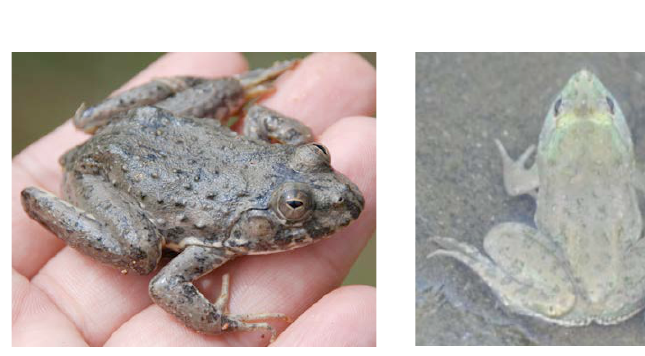
Image 3. Euphlyctis cyanophlyctis , Ngera Ama Ri, Samdrup Jongkhar. © Karma Wangdi